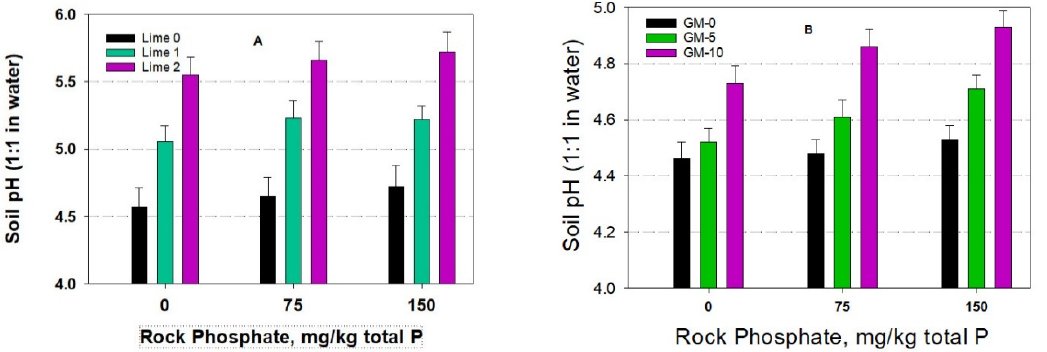
Figure 1. Soil pH as affected by lime and rock phosphate ( A ) with all green manure treatments combined, and by green manure and rock phosphate ( B ) in the no lime treatment. Error bars on top of larger bars are the standard deviation of the measured samples.